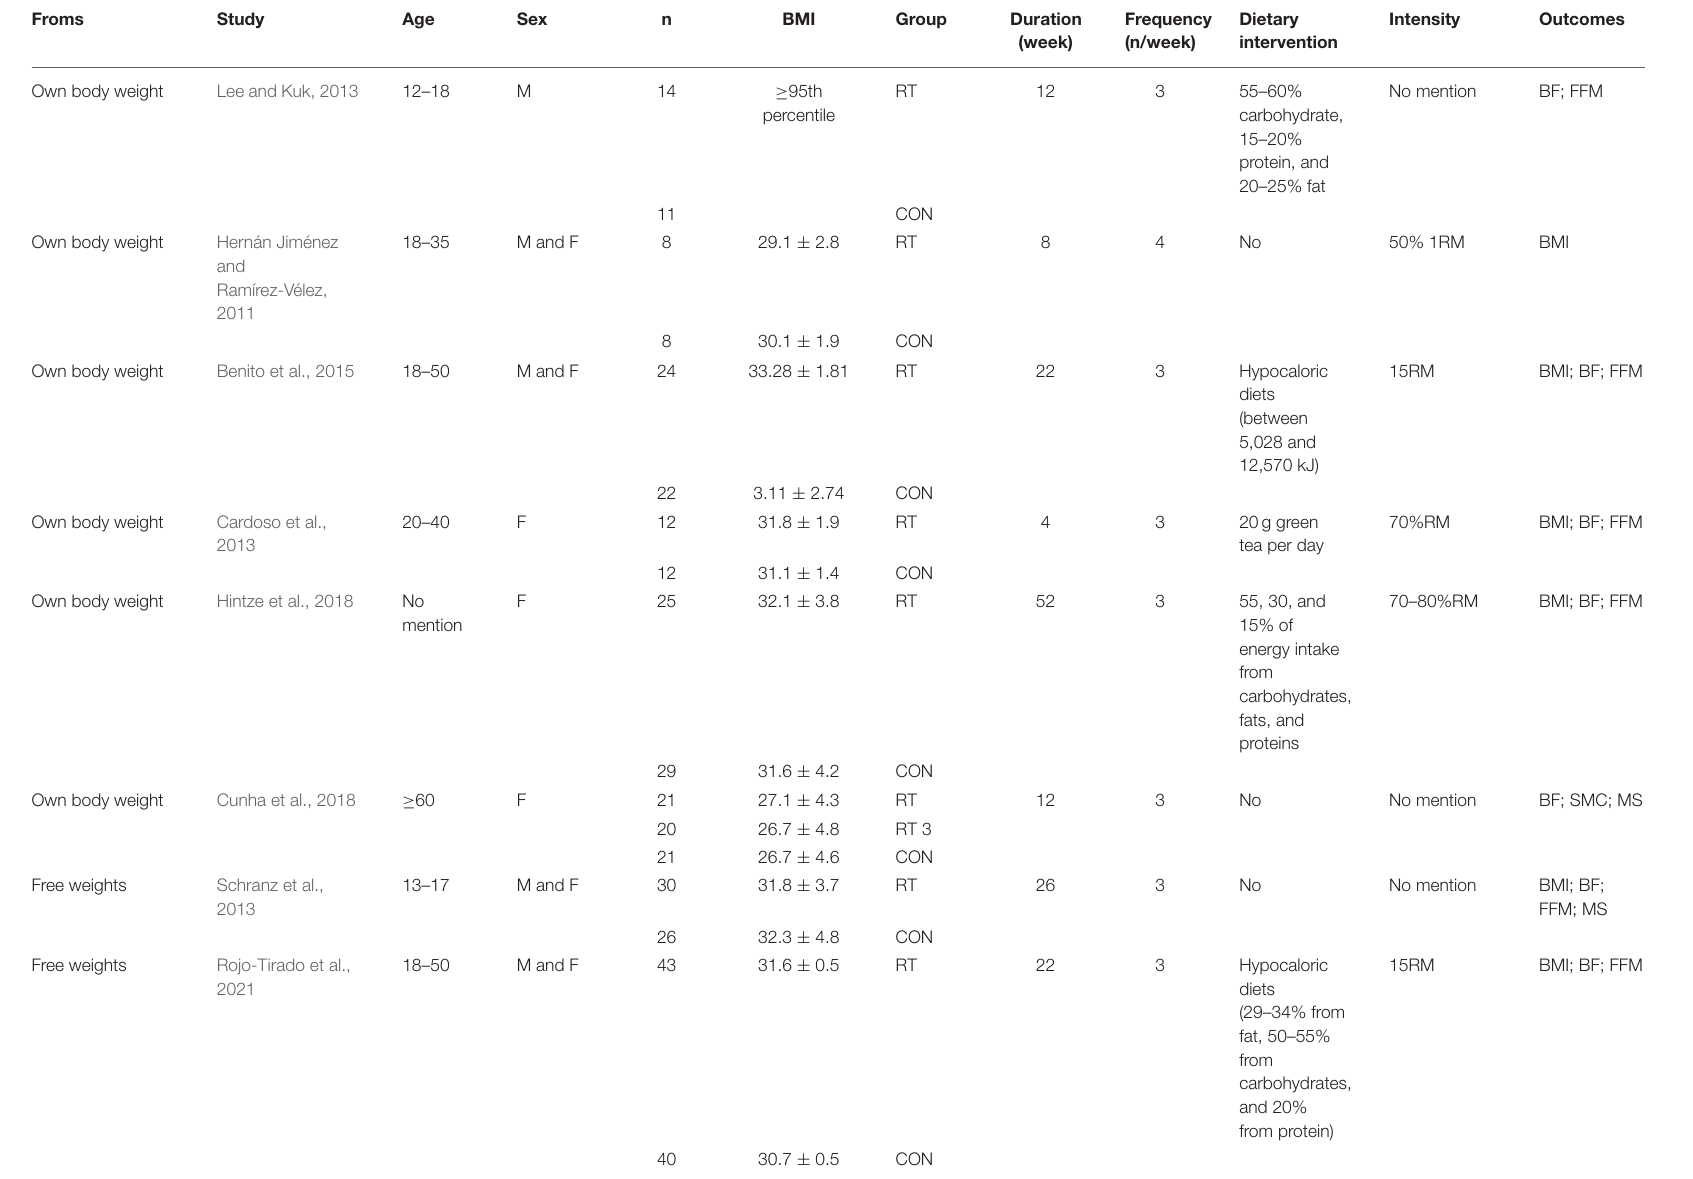
TABLE 1 | Characteristics of included studies.